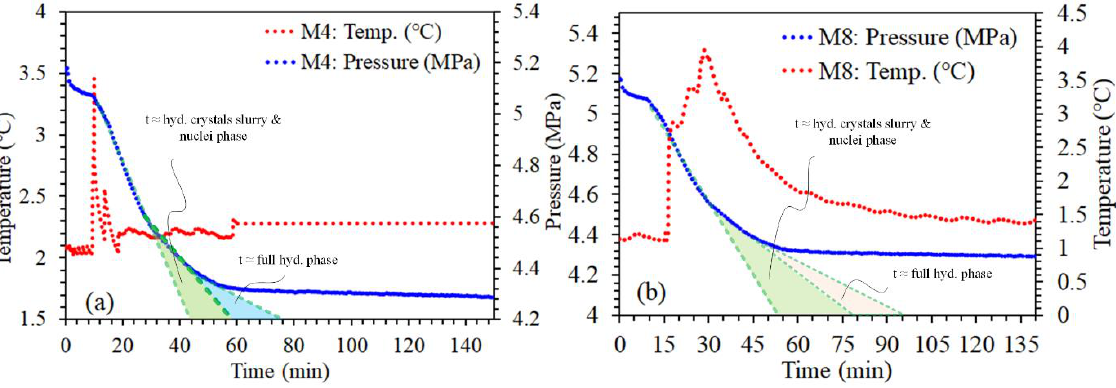
Figure 4. Comparison of temperature and pressure profile kinetic measurement of CH₄/DIW/IP + SDS ( a ) vs. CH₄/seawater/IP + SDS ( b